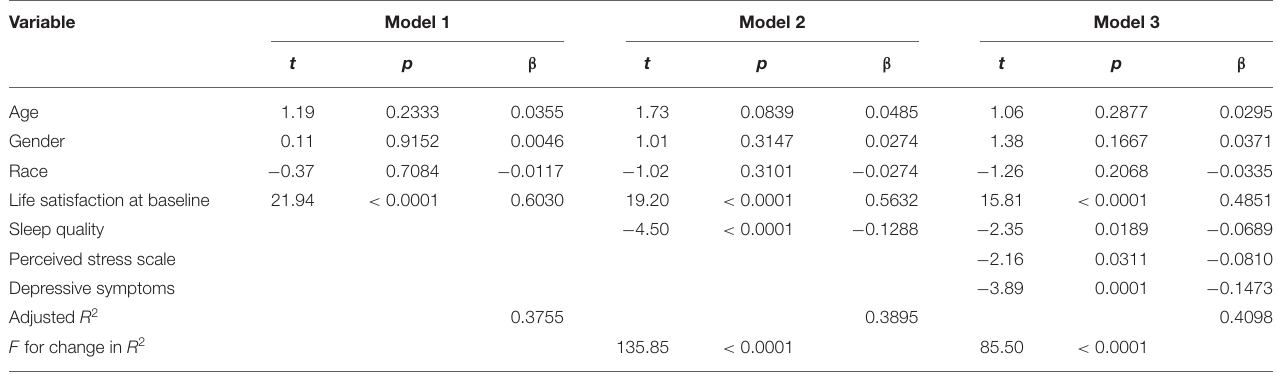
TABLE 2 | Summary of hierarchical regression analyses for life